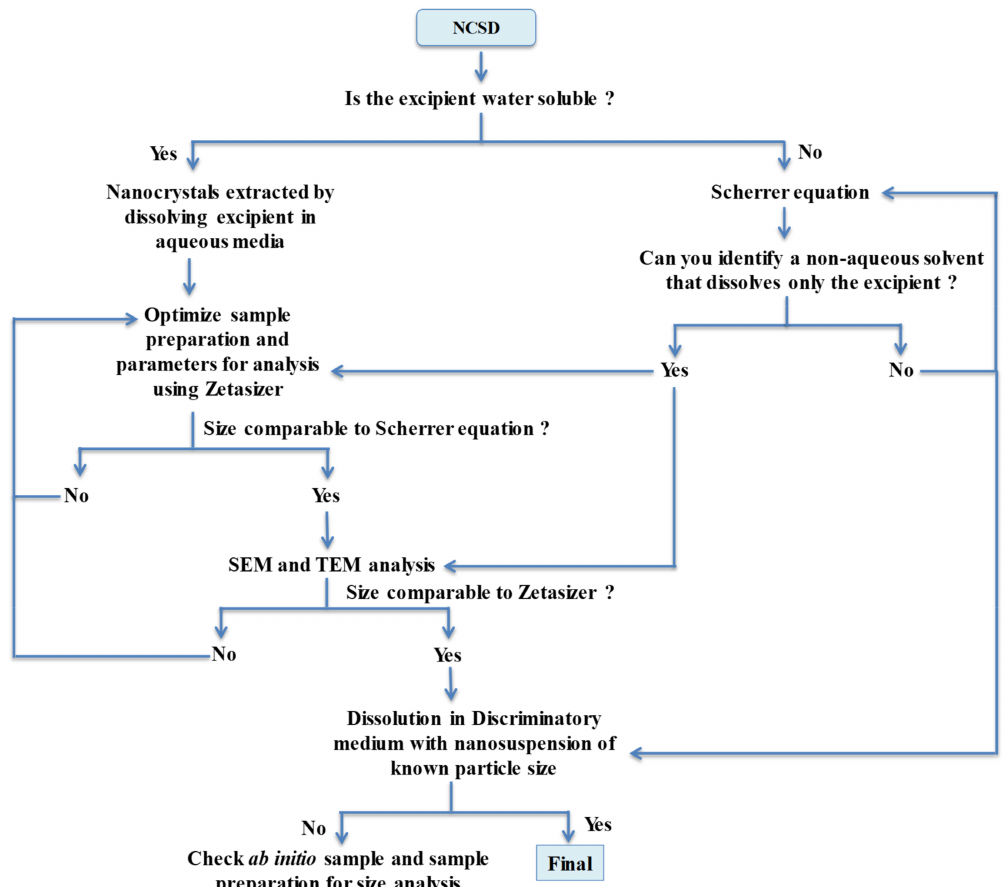
Figure 10. Decision tree for particle size determination of nanocrystals in